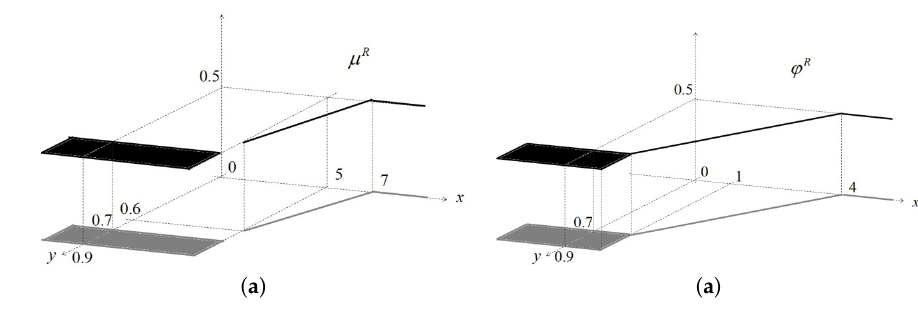
Figure 10. ( a ) µ R and ( b ) ϕ R according to Example